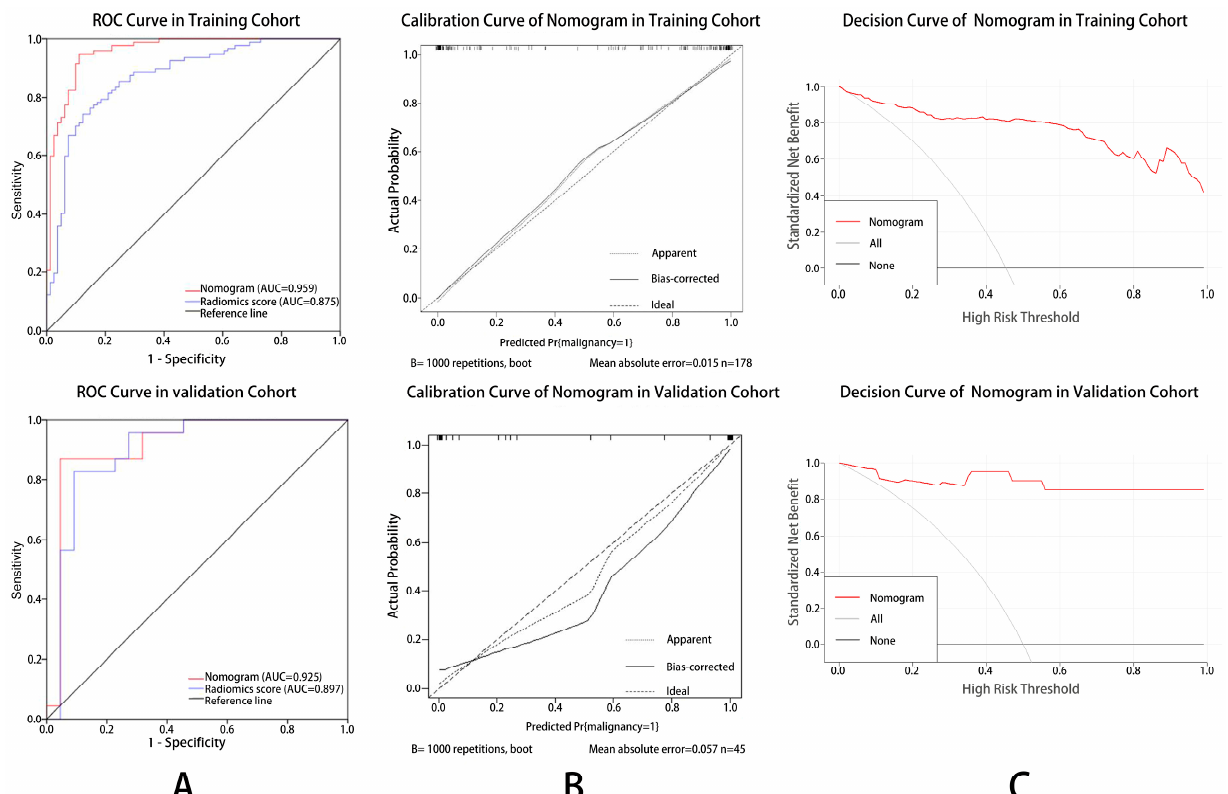
Figure 3. Radiomic nomogram. The radiomic nomogram was developed by combining the radiomic score, lesion size and BI-RADS 4 subcategory to distinguish benign and malignant BI-RADS 4 le- sions.